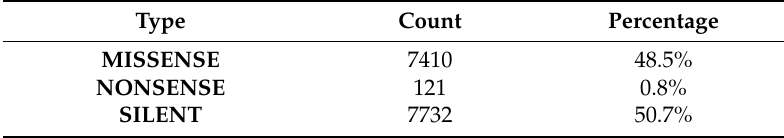
Table 6. SNP calling analysis. Number and percentage of effects by functional